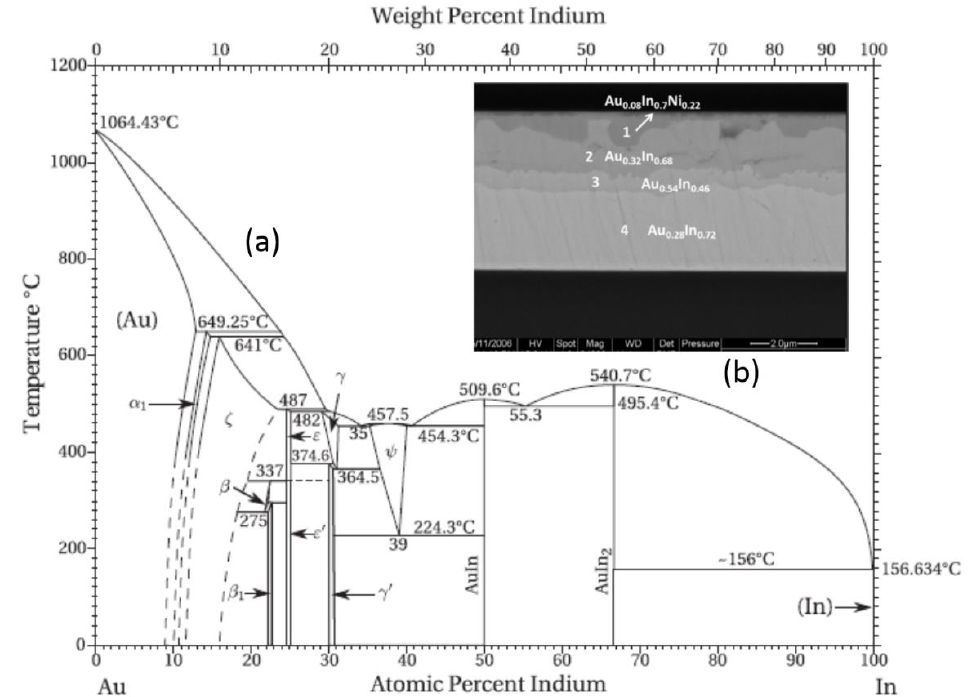
Figure 14. ( a ) Gold-Indium (Au-In) phase diagram; ( b ) Scanning electron microscope (SEM) micrograph depicting a seal structure with four different Au-In intermetallic compound (IMC) phases. Au-In-Nickel (Ni) IMC is shown in phase 1, likely the ϒ ' Au-In in phase 2, likely AuIn in phase 3, and AuIn 2 in phase 4 [148]. Reprinted with permission from the Institute of Electrical and Electronics Engineers (IEEE).